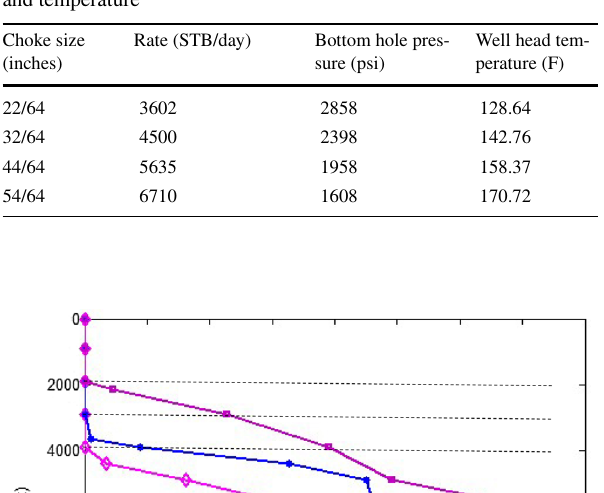
Fig. 22 Sensitivity analysis; effect of choke size on cumulative pro- duction after 1000